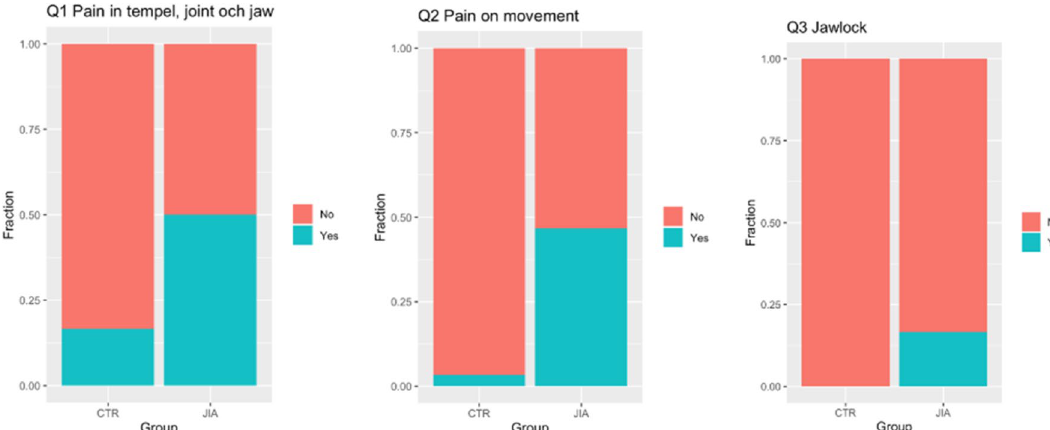
Figure 1. This figure shows the distribution of temporomandibular symptoms according to the 3Q/TMD questions in the 30 children with a diagnosis of JIA and in the 30 healthy controls. The JIA group had significantly more orofacial and functional pain (Q1 and